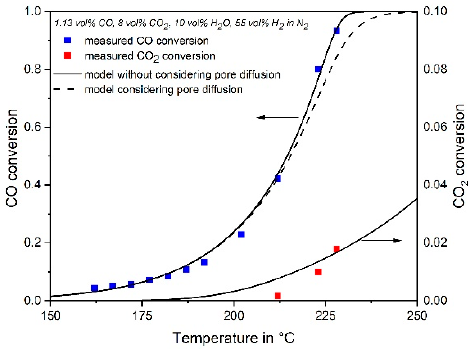
Figure 9. Measured and modeled CO and CO 2 conversion of a feed gas with 1.13 vol% CO, 8% CO 2 , 10% H 2 O and 55% H 2 in N 2 ( 𝜏 (200 °C) = 230 kg·s·m − 3 , p = 1 bar).